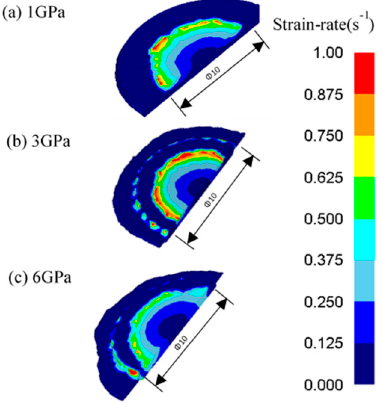
Figure 4. Distribution of strain rate on the half-disc surfaces and along the disc longitudinal sections for samples after a 1/2 turn with ( a ) 1 GPa; ( b )3 GPa; and ( c ) 6 GPa.